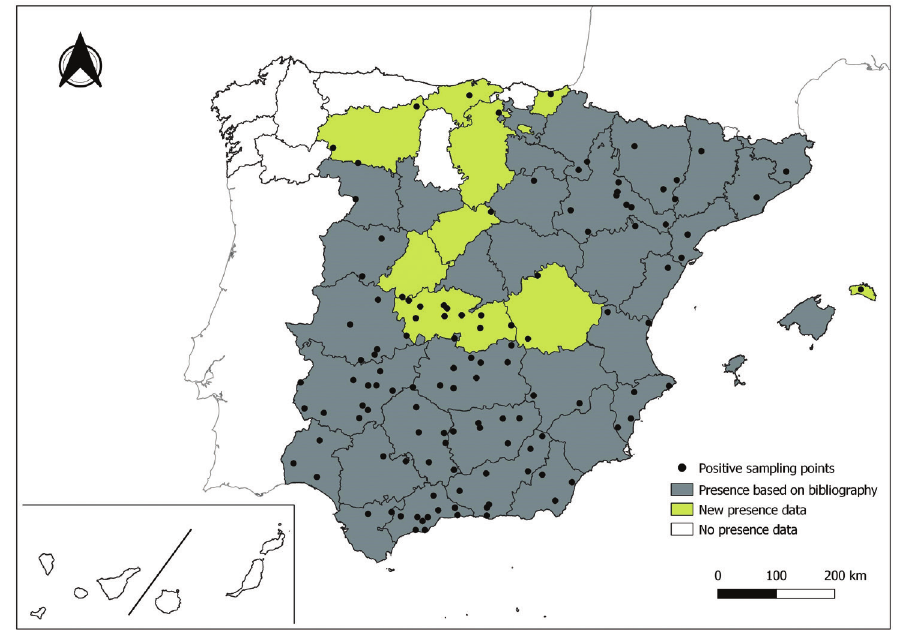
Figure 3. Distribution of Phlebotomus papatasi in Spain.